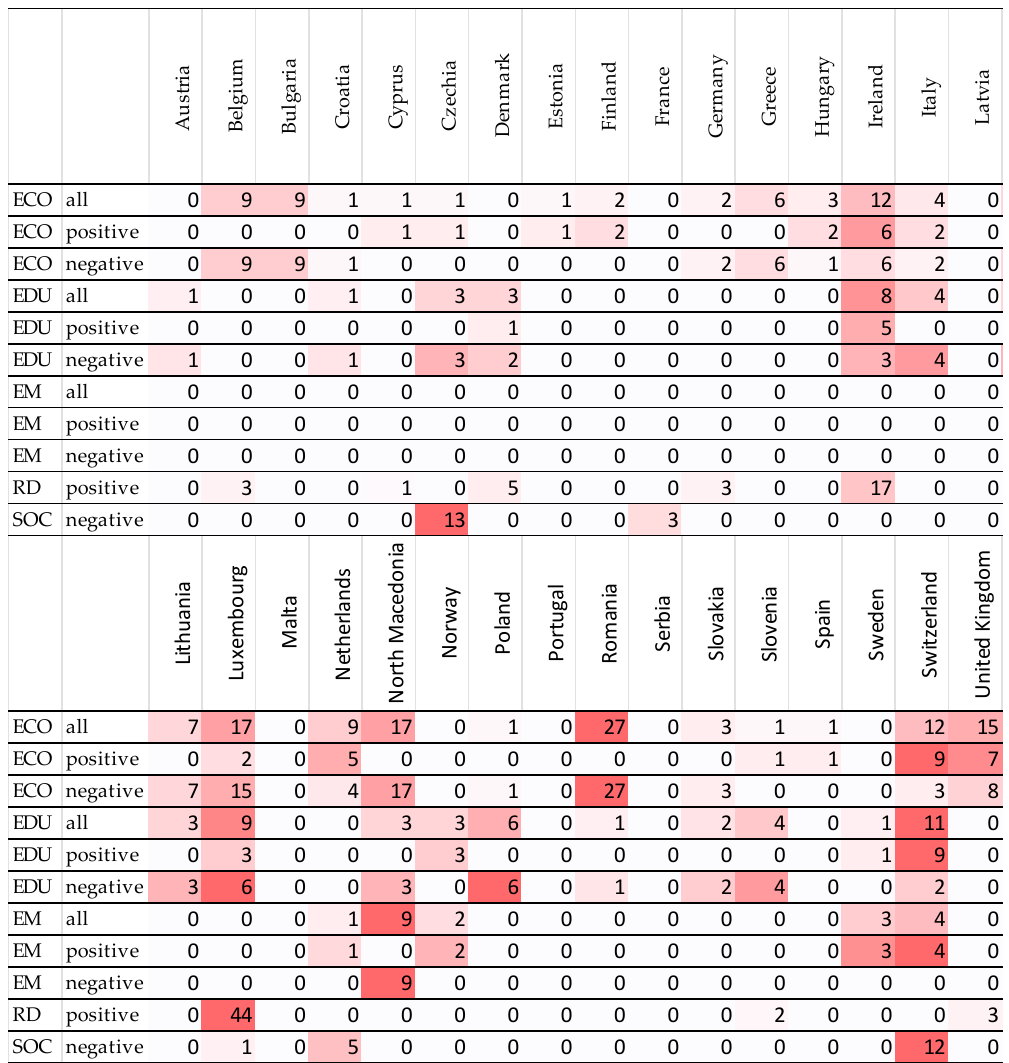
Figure 25. Summary of long precedencies.